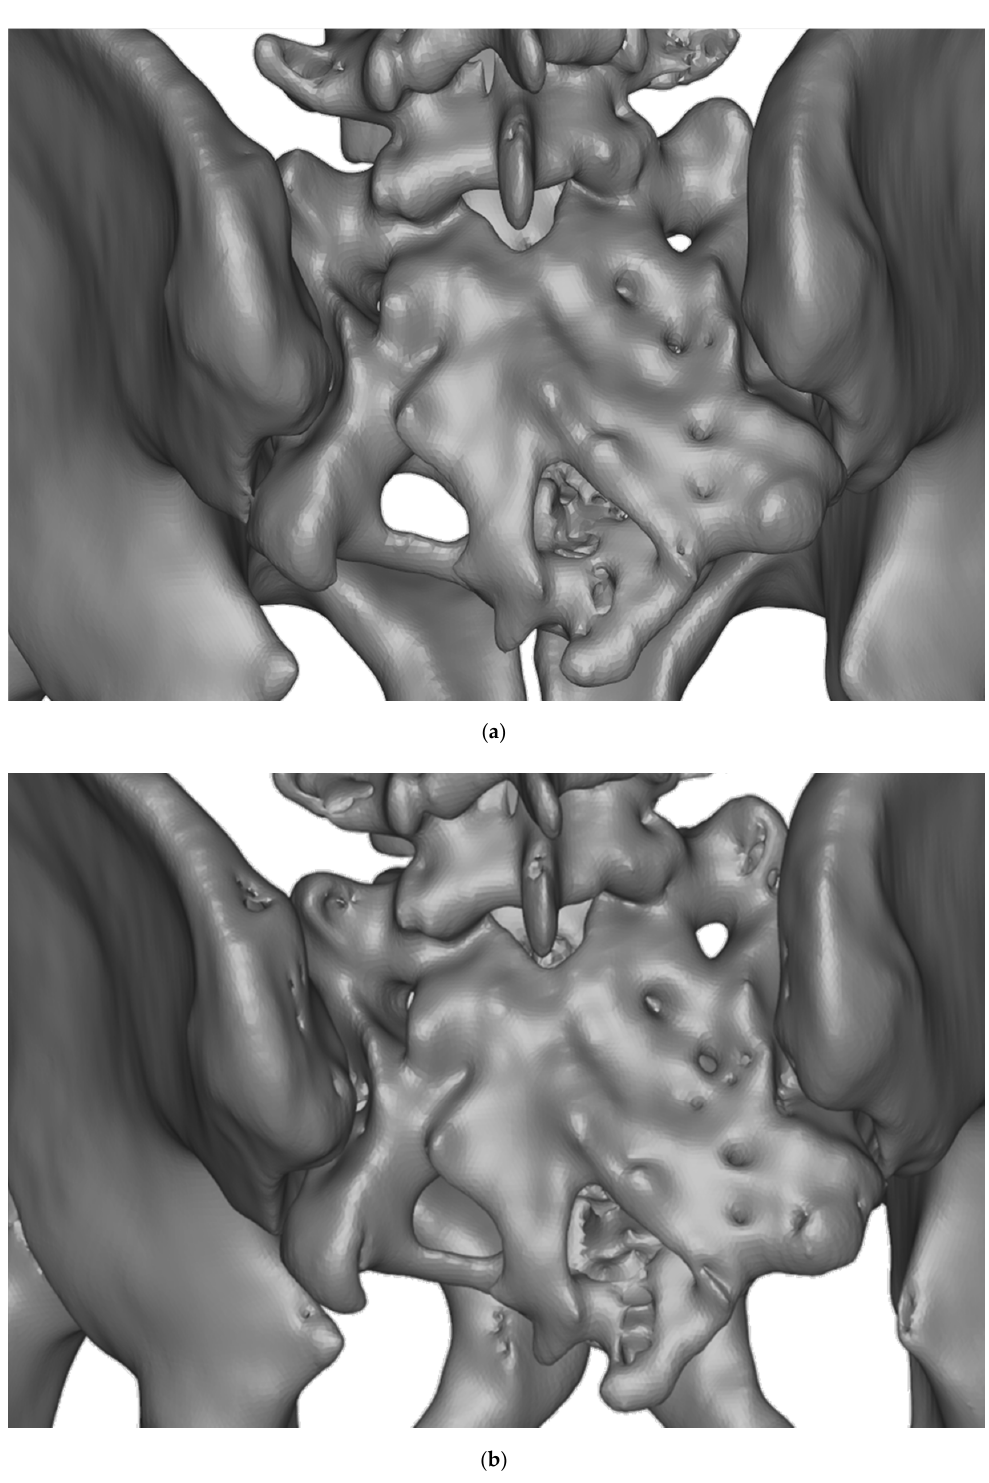
Figure 2. Three-dimensionally reconstructed models with differences due to the density values selected for each segmentation. The high density segmentation ( b ) provides and enhanced representation of bone microstructure than the reconstruction including lower densities ( a ), in which the presence of cartilage and surrounding soft tissues and fluids prevents the reconstruction of actual existing channels, which are relevant for the surgical procedure, especially as regarding the presence of surgical paths for inserting the electrodes for stimulation. Scale bar: 90mm.